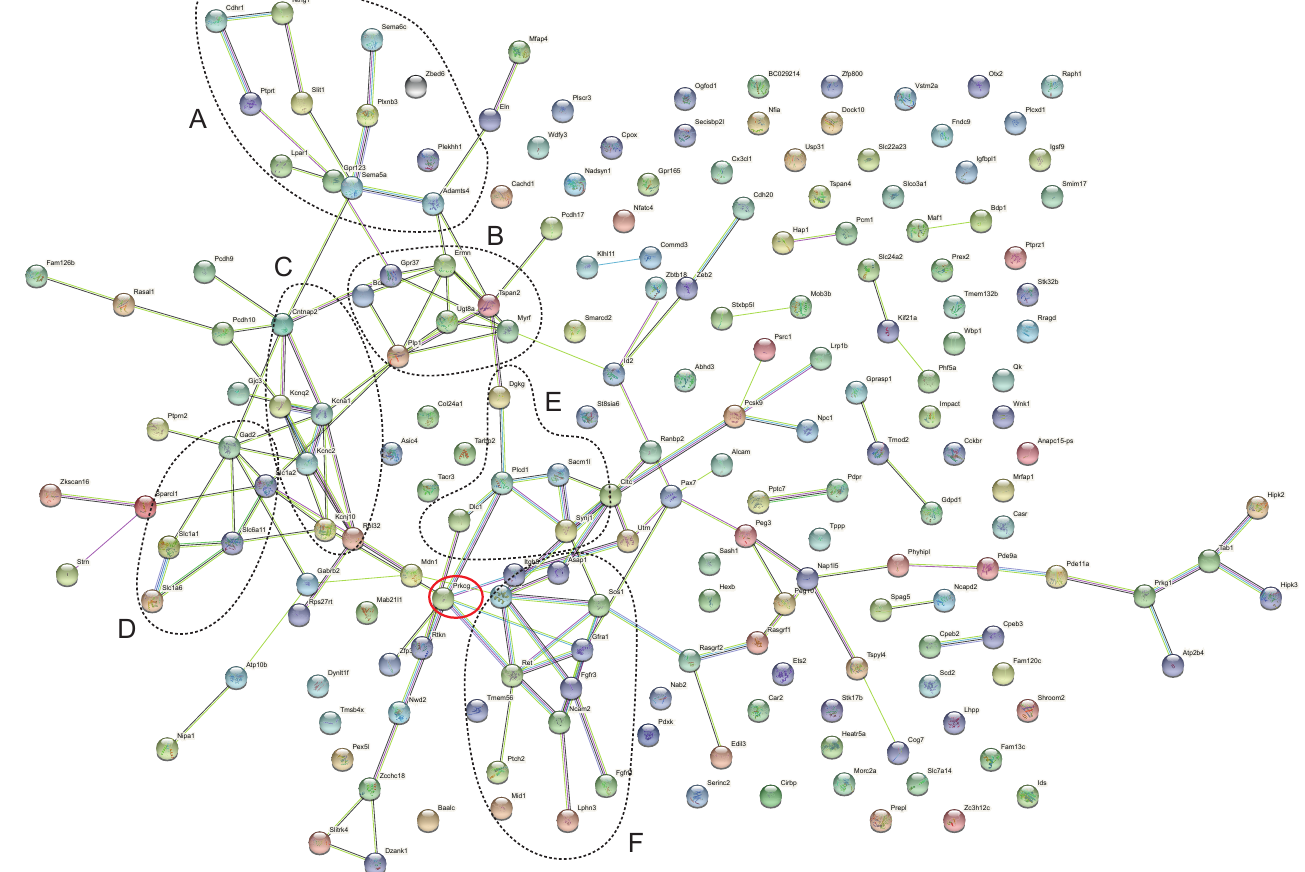
Figure 2. In the output of String analysis using the dataset derived from Homo PKCg-A24E, edges represent specific and meaningful protein–protein associations. Interaction types are coded by color. The analysis was carried out using PKC γ as an anchor point (red circle). DEGs were grouped into clusters on the basis of analyses of known and predicted protein–protein interactions (individual clusters enclosed by dotted lines). Individual gene names are visible after magnifying the